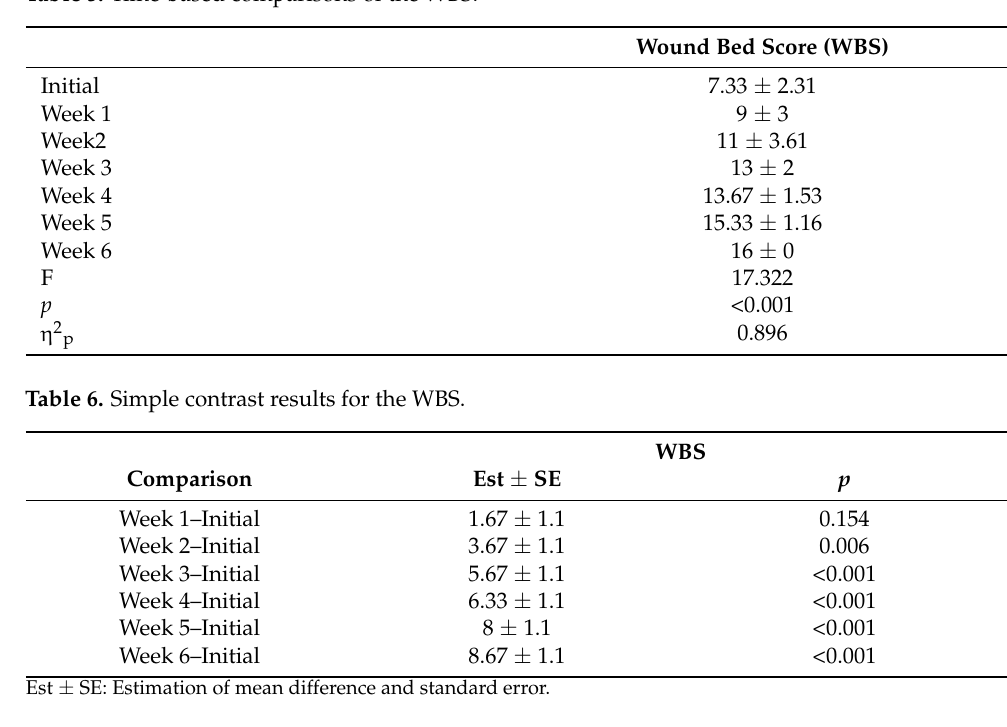
Table 5. Time-based comparisons of the WBS.